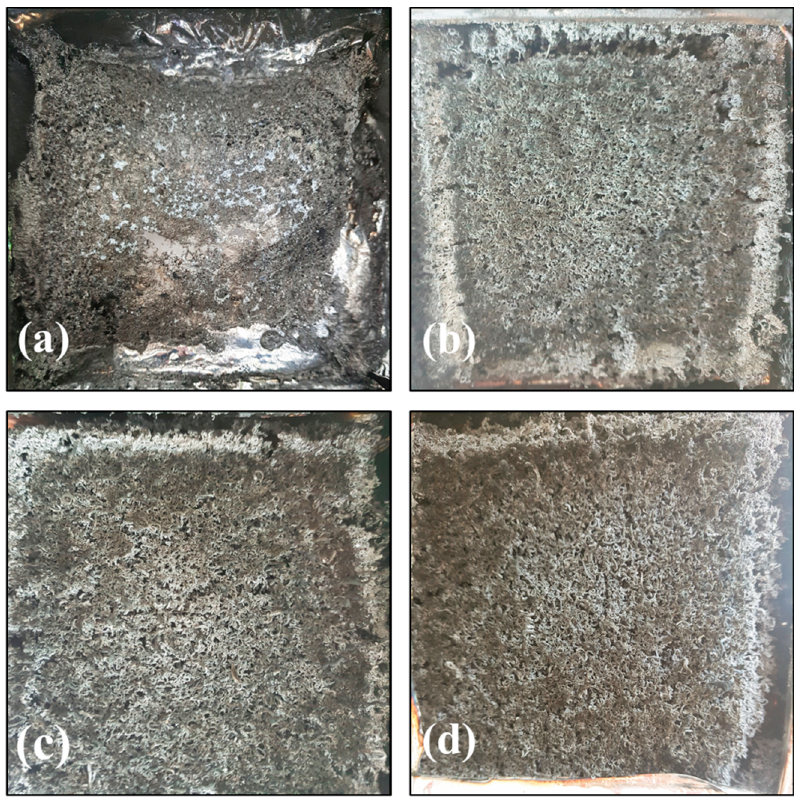
Figure 5. Digital photos of the residues of RPUF samples: ( a ) RPUF; ( b ) FRPU; ( c ) FRPU/GO; and ( d ) FRPU/fGO.